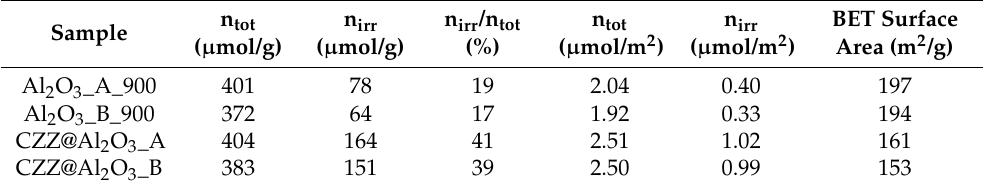
Figure 6. Differential heat (Q diff ) vs. uptake for ammonia adsorption expressed in µmol/g for Al 2 O 3 _A_900 ( a ), Al 2 O 3 _B_900 ( b ), and for the corresponding composites. Open symbols refer to re-adsorption after overnight evacuation. Dash lines refer to the cut-off value between physisorption and chemisorption (60 kJ/mol). Table 2. Ammonia adsorption microcalorimetric results for Al 2 O 3 _A_900, Al 2 O 3 _B_900, and for the corresponding composites.